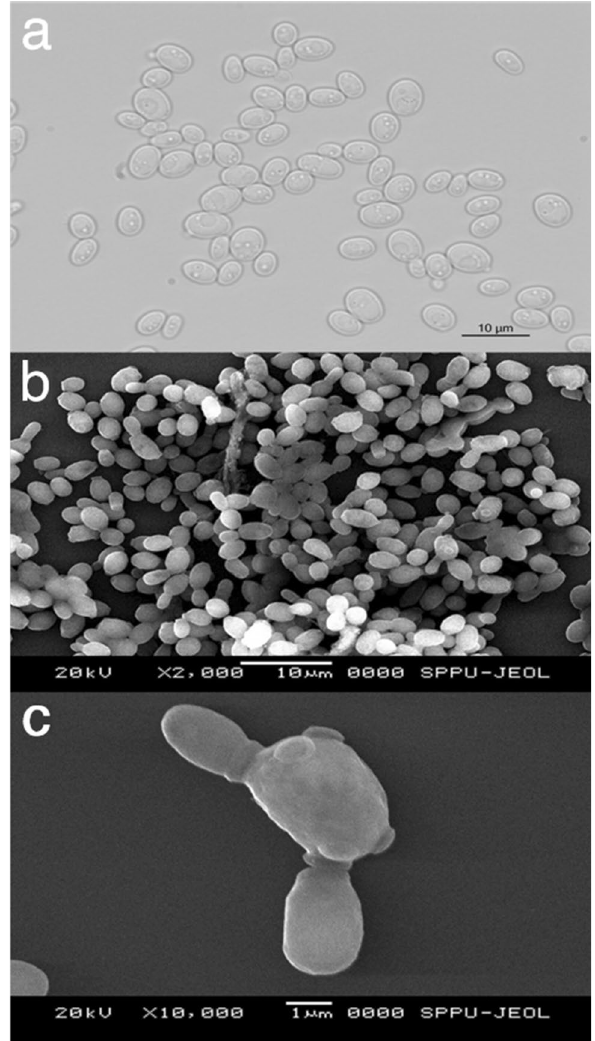
Figure 3. Cell morphology of NCIM 3590. ( a ) Light microscopy and ( b ) SEM and micrographs of NCIM 3590 strain grown on YNBG broth for 72 h. Micrographs showing Bar 10 µm. ( c ) shows budding and the arrows indicates bud scar. Bar 1